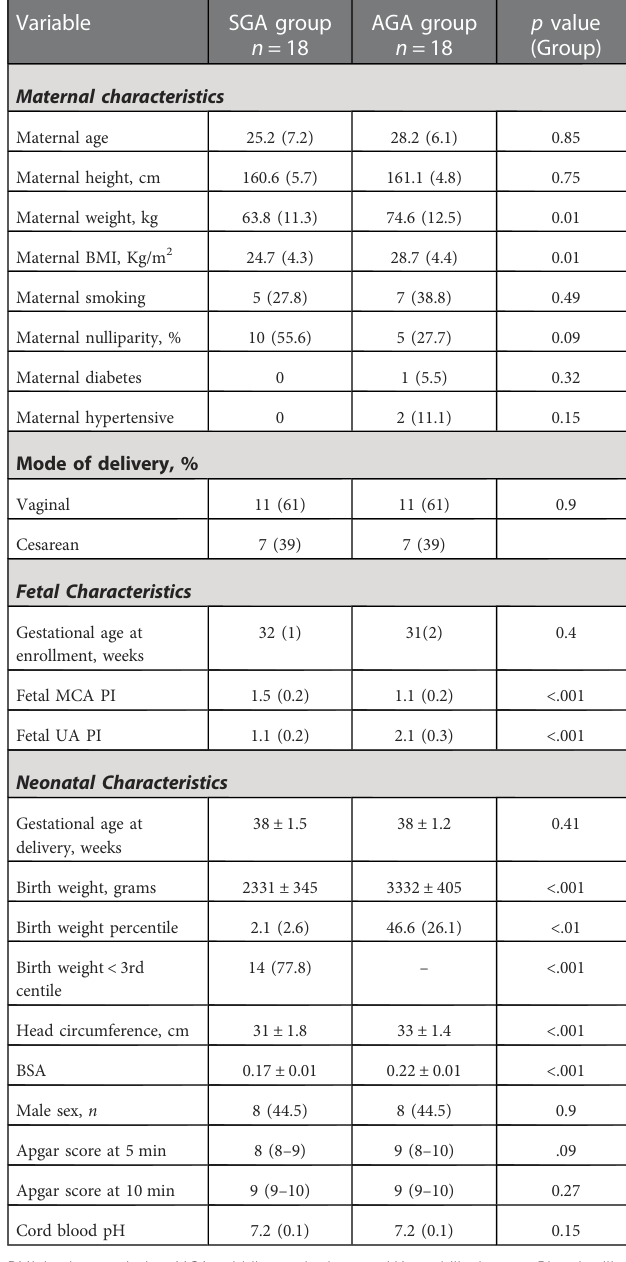
TABLE 1 Demographic indices of the SGA infants and AGA controls.